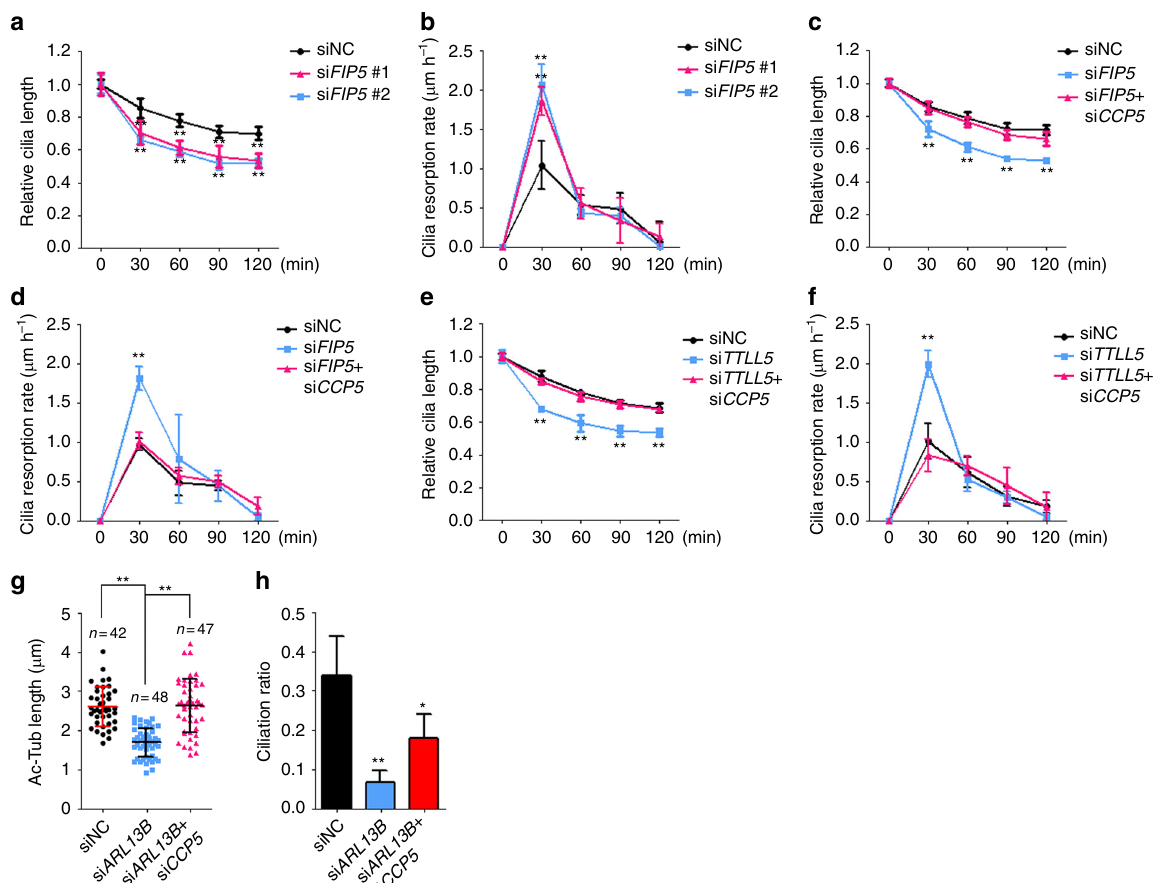
Fig. 5 Axonemal hypoglutamylation promotes cilia disassembly. a , b hTERT-RPE-1 cells were serum starved for 24 h and then cultured in the medium containing 20% FBS for the indicated times. Relative cilia length ( a ) and resorption rate ( b ) were measured and quanti fi ed at the indicated times. c , d CCP5 knockdown restores relative cilia length ( c ) and resorption rate ( d ) in FIP5 -depleted hTERT-RPE-1 cells. e , f CCP5 knockdown restores relative cilia length ( e ) and resorption rate ( f ) in TTLL5 -depleted hTERT-RPE-1 cells. g , h CCP5 knockdown partially restored ciliogenesis defect in ARL13B knockdown cells by rescuing both cilia length ( g ) and ciliation ratio ( h ). Center values represent mean. Error bars represent s.d. N value: cilia number accessed from at least six fi elds. In all experiments, hTERT-RPE-1 cells were treated with indicated siRNAs for 48 h and serum starved for 24 h. Data in a – f and h are the statistical analysis of three independent experiments. Statistical signi fi cance was determined using unpaired Student ’ s t test. * p < 0.05; ** p <